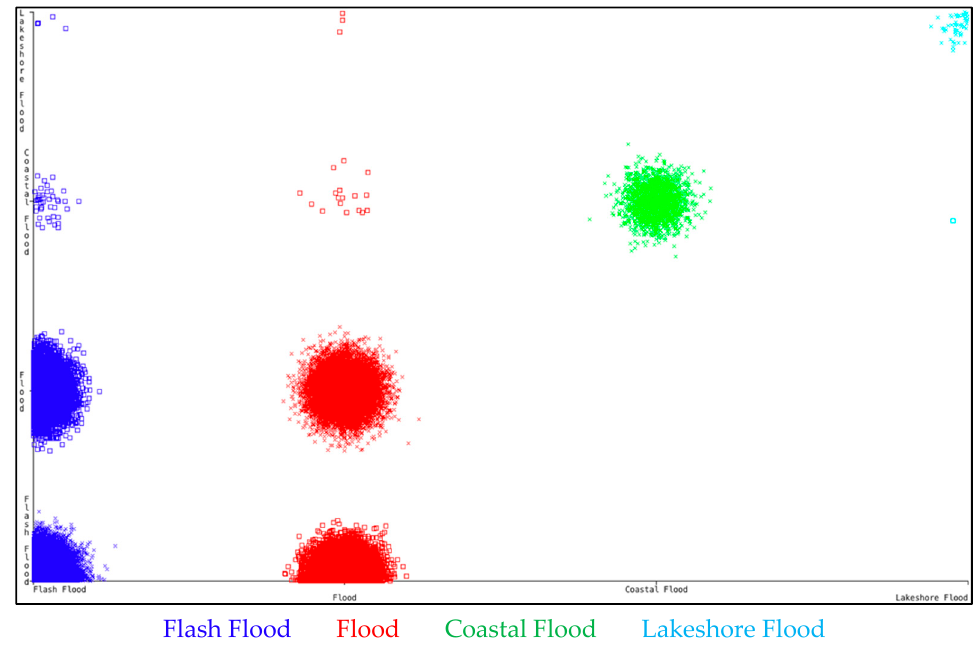
Figure 7. Visual classifier error for Random Forest model in Weka. The crosses indicate correctly classified instances and squares refer to misclassified instances.